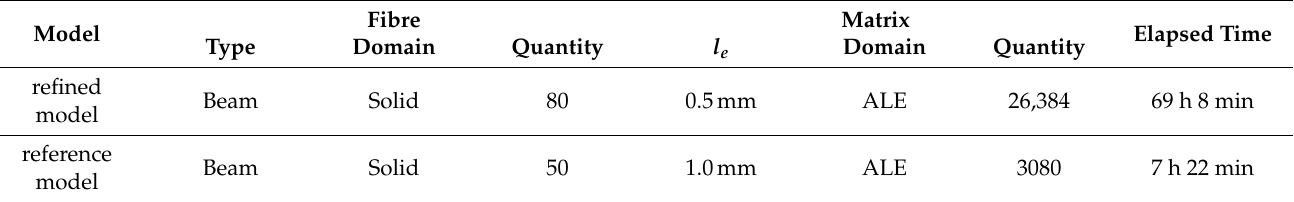
Table 11. Numerical setup for the refined rheological FSI